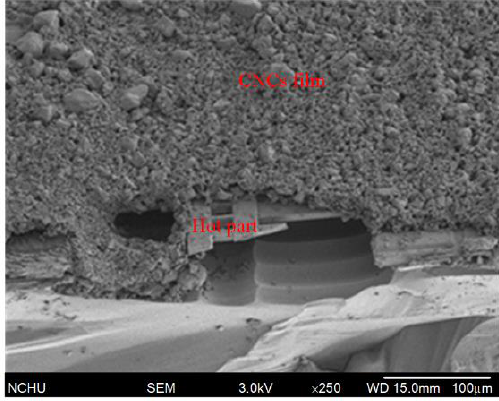
Figure 11. SEM picture of the microgenerator with CNCs film.